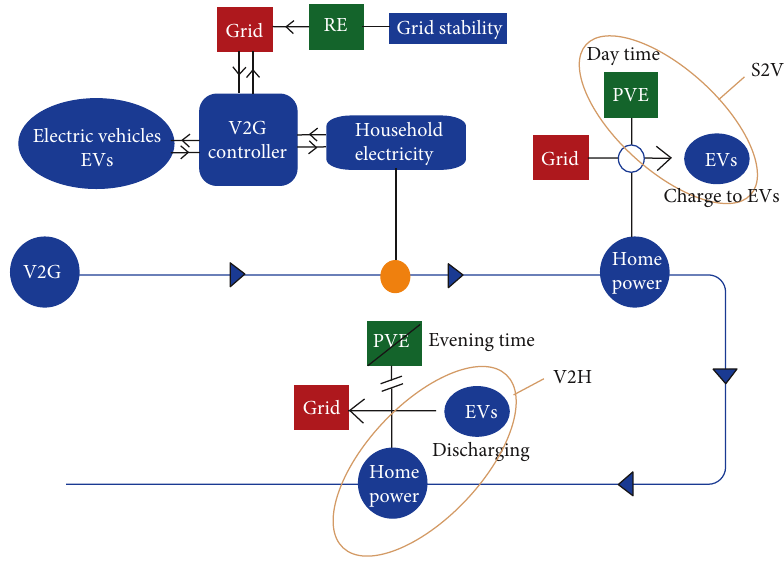
Figure 3: The relationship between electric vehicles and the grid.